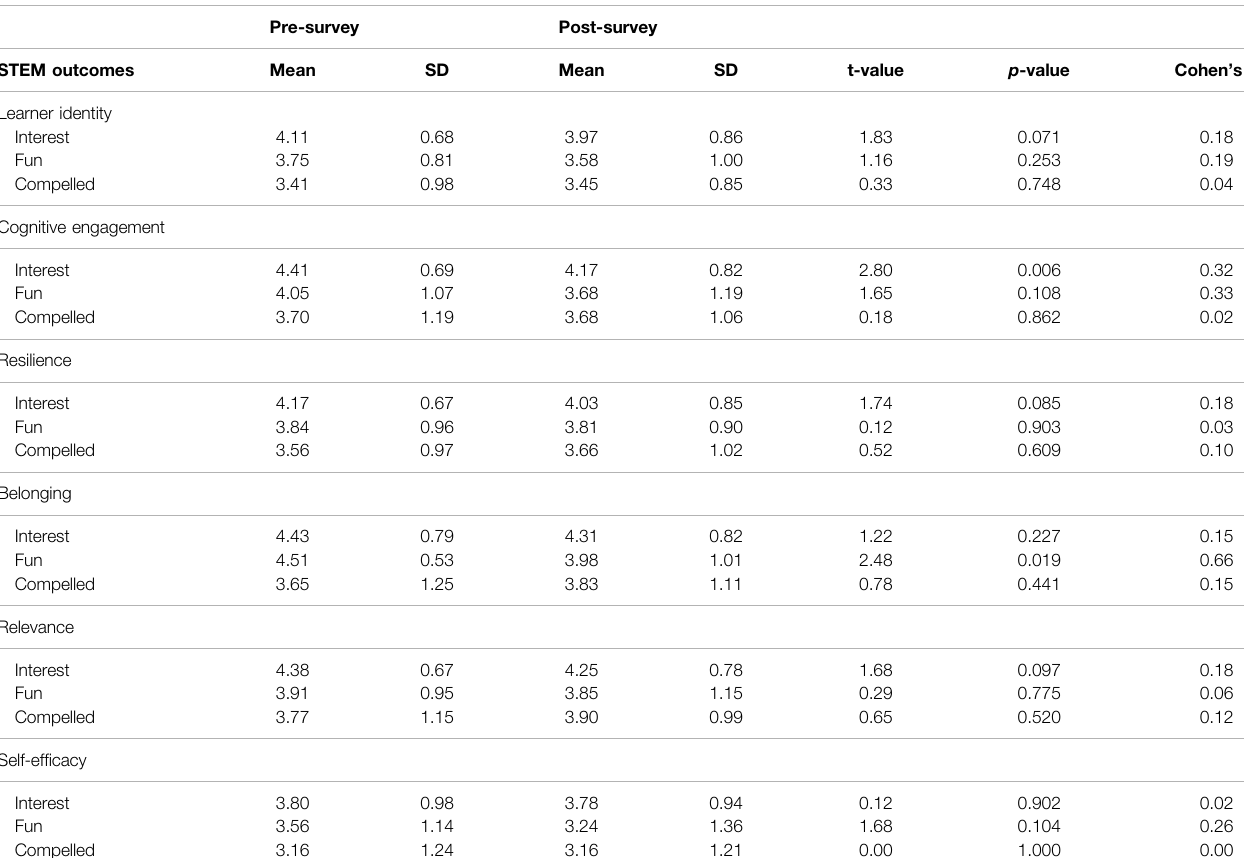
TABLE 3 | Comparison of changes in pre- and post-survey STEM outcomes by subgroup. Pre-survey